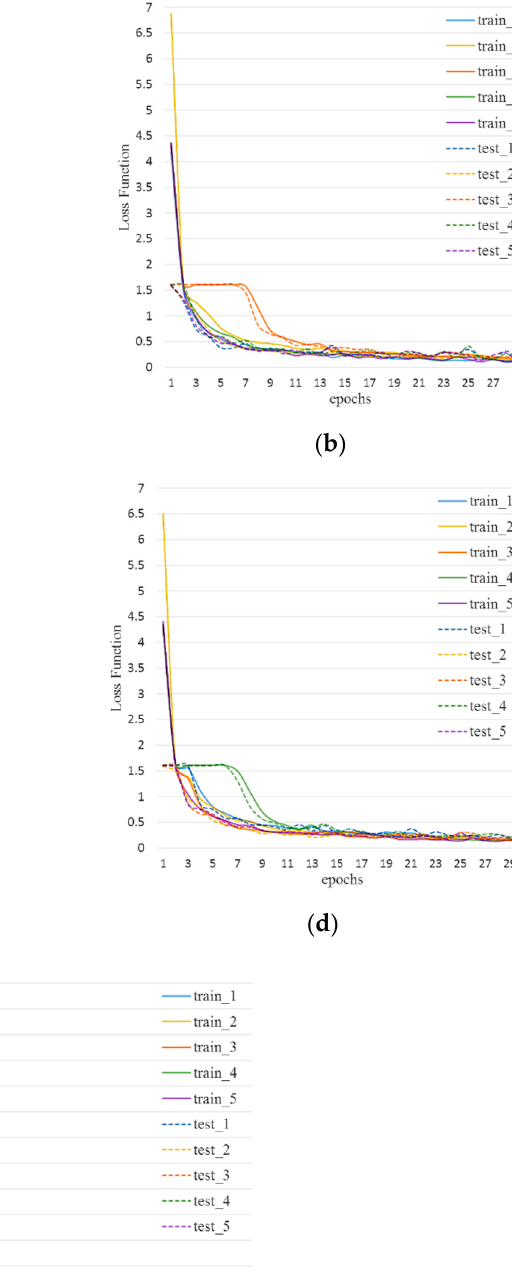
Figure 12. CCE loss graph with five train-test runs of cross-validation for the second case when motor load condition is ignored as input label. Figure 13a shows the average loss function difference between the combined five models when the motor loading condition is used as an input label, and the model when the motor loading 00.51 1.52 2.5 3